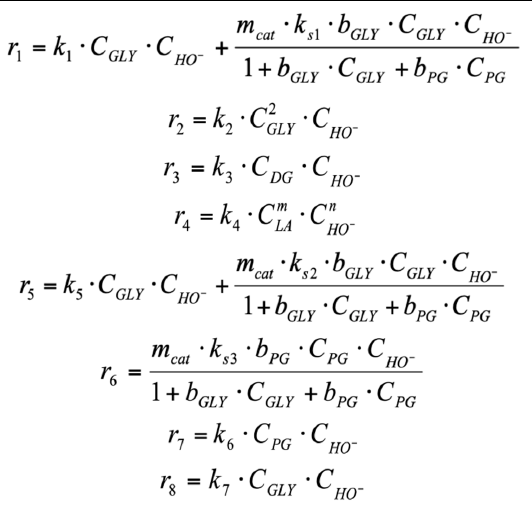
Table 4. Reaction rate equations for the Model.